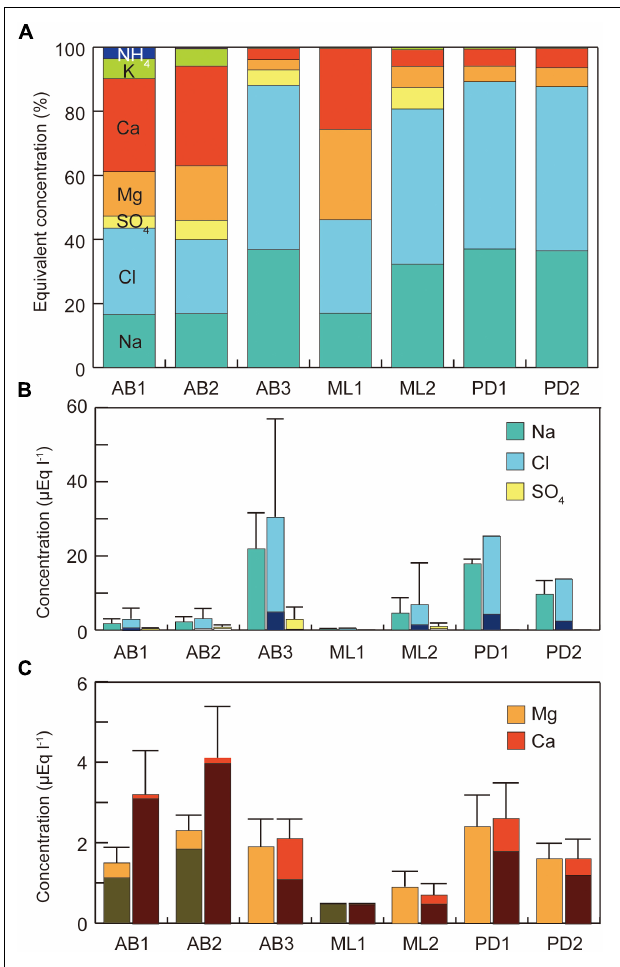
FIGURE 2 | Variations in major soluble ions in melt water at the study sites on three glaciers in Svalbard. (A) Percentages of major ions; (B) concentrations of sodium, chloride, and sulfate, (C) concentrations of calcium and magnesium. All concentration represents raw value without sea-salt correction. Error bar = standard deviation.